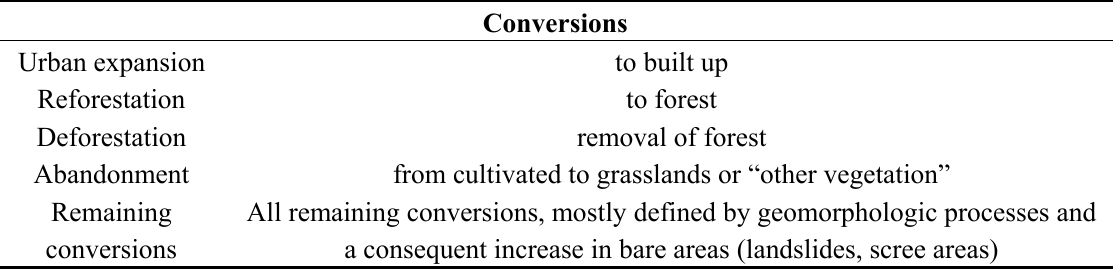
Table 3. Definitions and assumptions on land cover